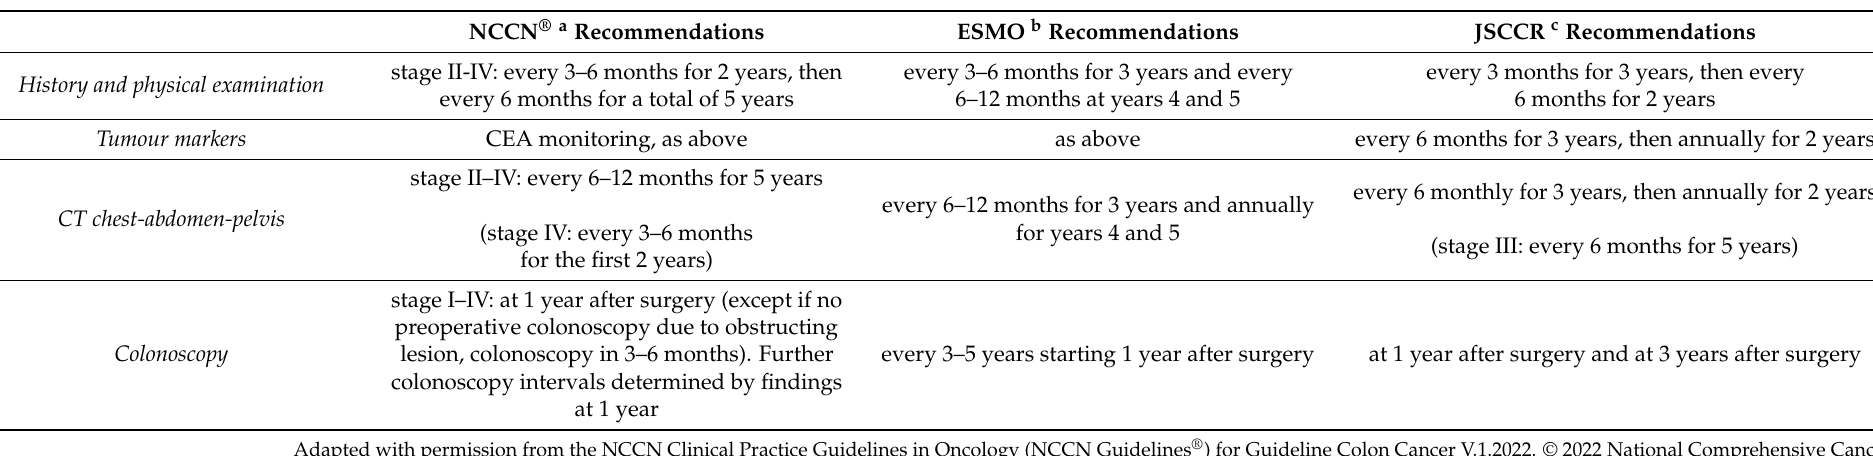
Table 5. Colon cancer: Postoperative follow-up.